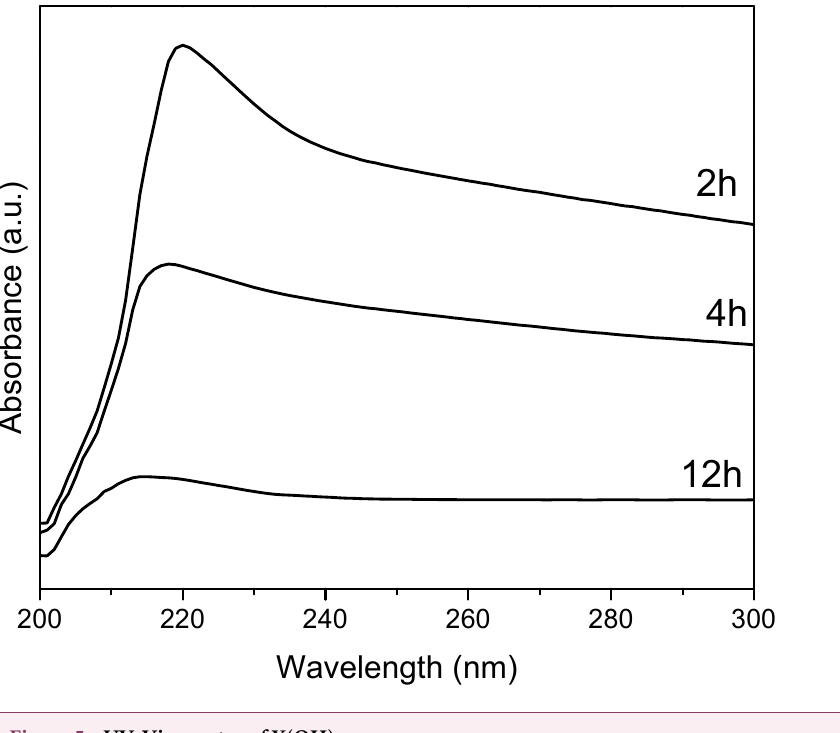
Figure 5 UV-Vis spectra of Y(OH) 3 .